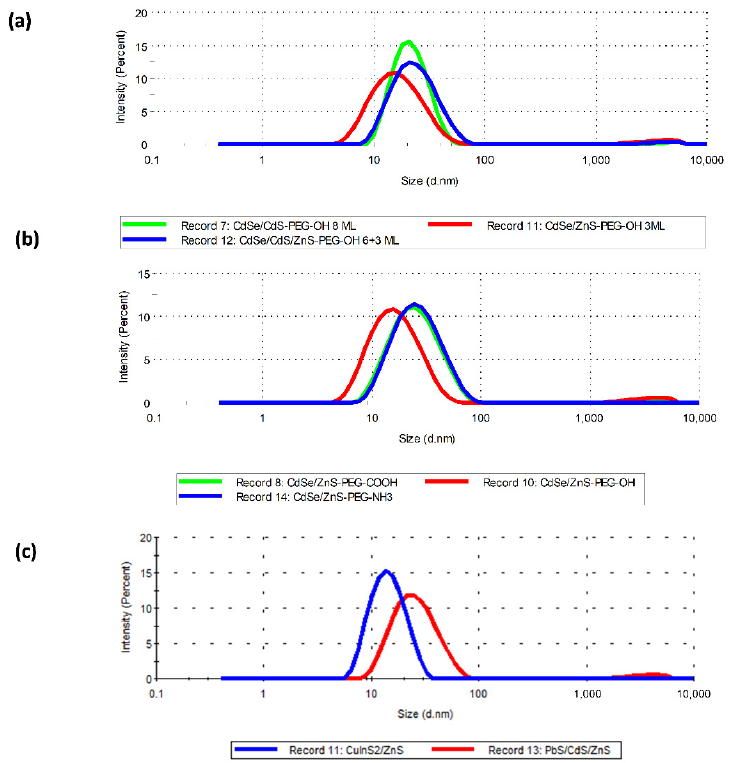
Figure 2. Estimation of the hydrodynamic diameter of quantum dots (QDs) by the dynamic light scattering method: ( a ) QDs with different structures of the inorganic shell; ( b ) QDs with different structures of the organic shell; ( c ) QD-PEG-OH with different cores.